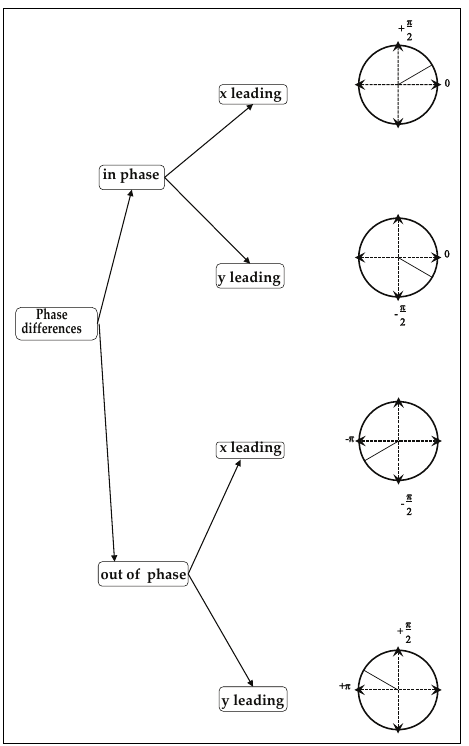
Figure 2. Interpretative diagram of the different phase differences. Source: Own elaboration from Schmidbauer et al. [18] and Aguiar-Conraria and Soares